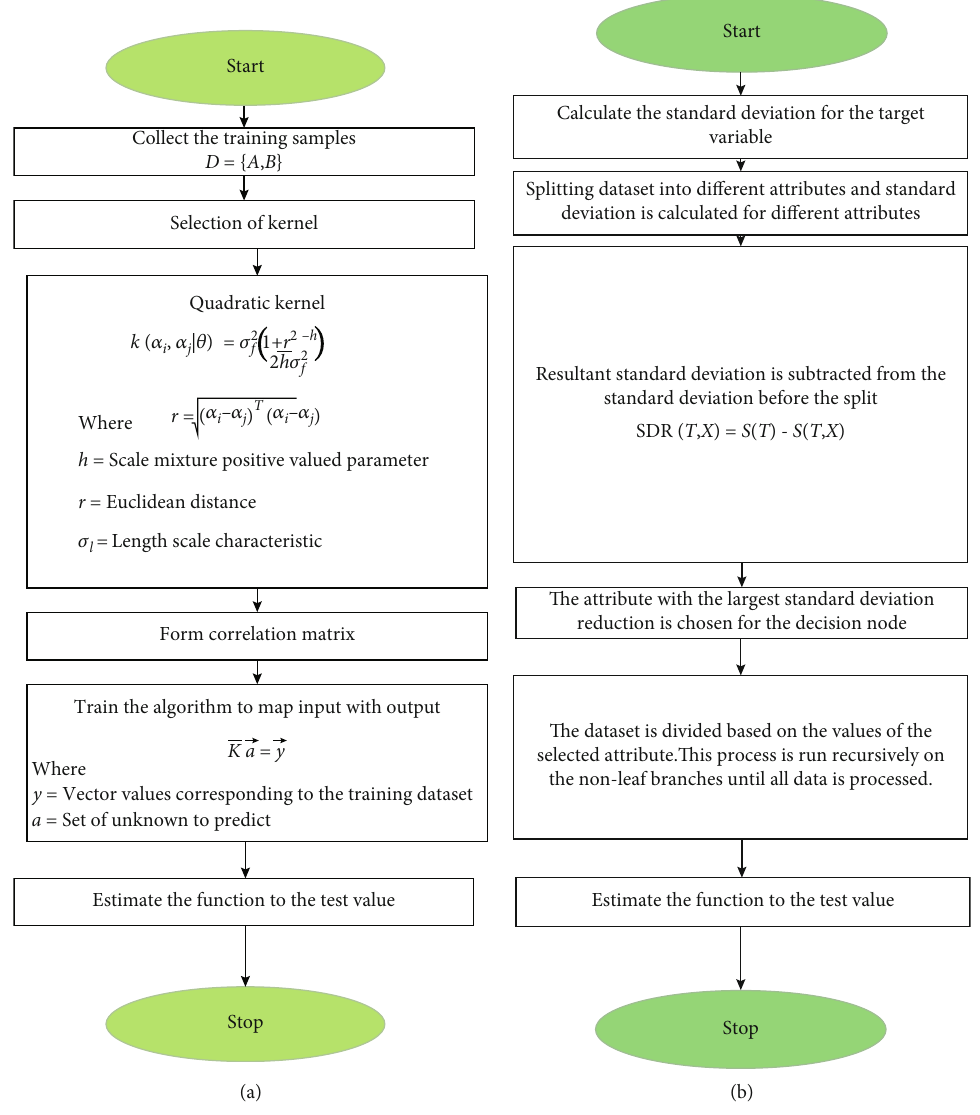
Figure 4: Algorithm of the (a) quadratic support vector machine and (b) decision